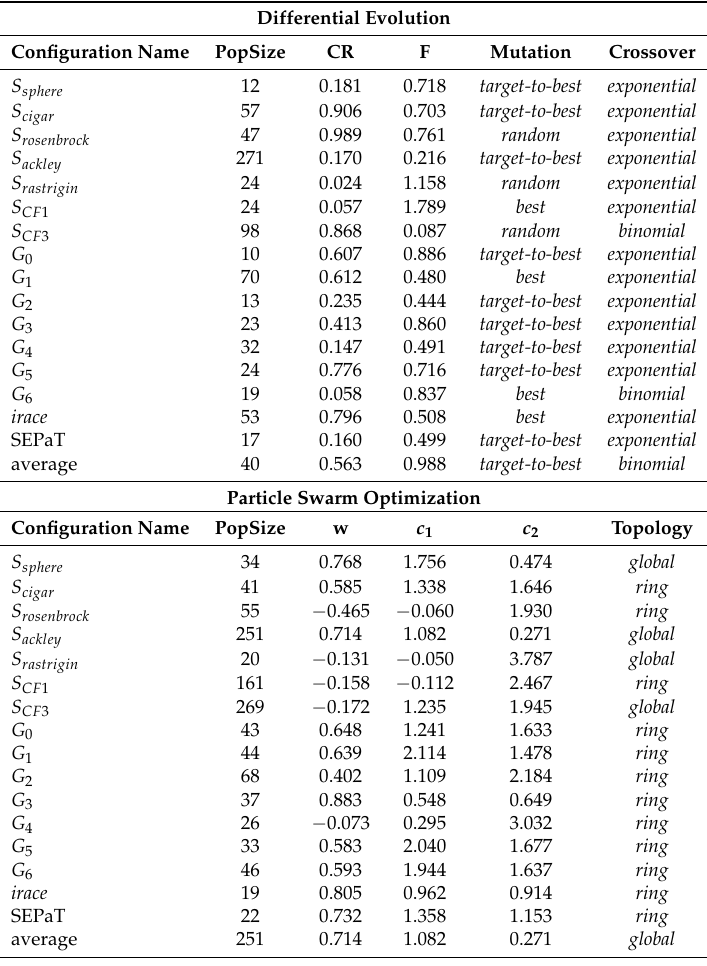
Table 8. The seven DE and PSO best-performing configurations generated by EMOPaT for each “training” function (denoted by S, for specialist, followed by the name of the function); the seven configurations that never achieved bad results in any of them (denoted by G, for generalist); the parameter sets found by irace and by SEPaT; and the single generalist configuration obtained by normalizing fitness values (see